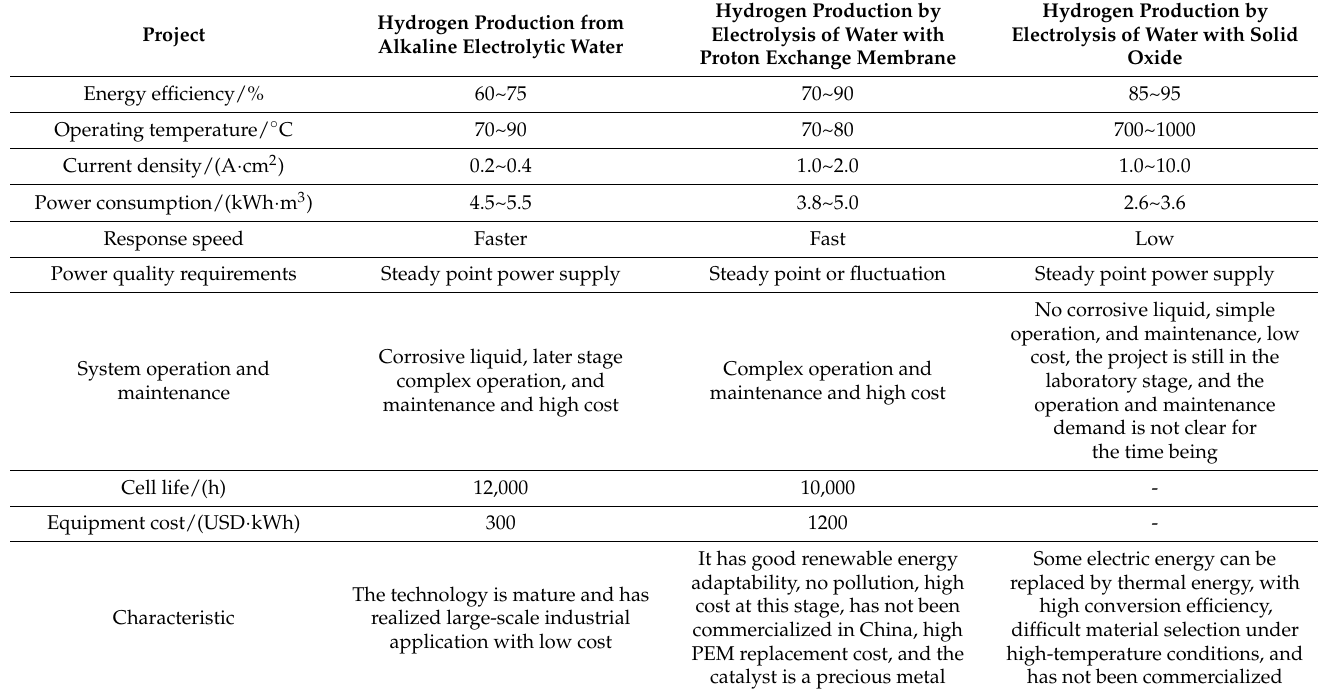
Table 5. Comparison of three typical hydrogen production technologies from electrolytic water